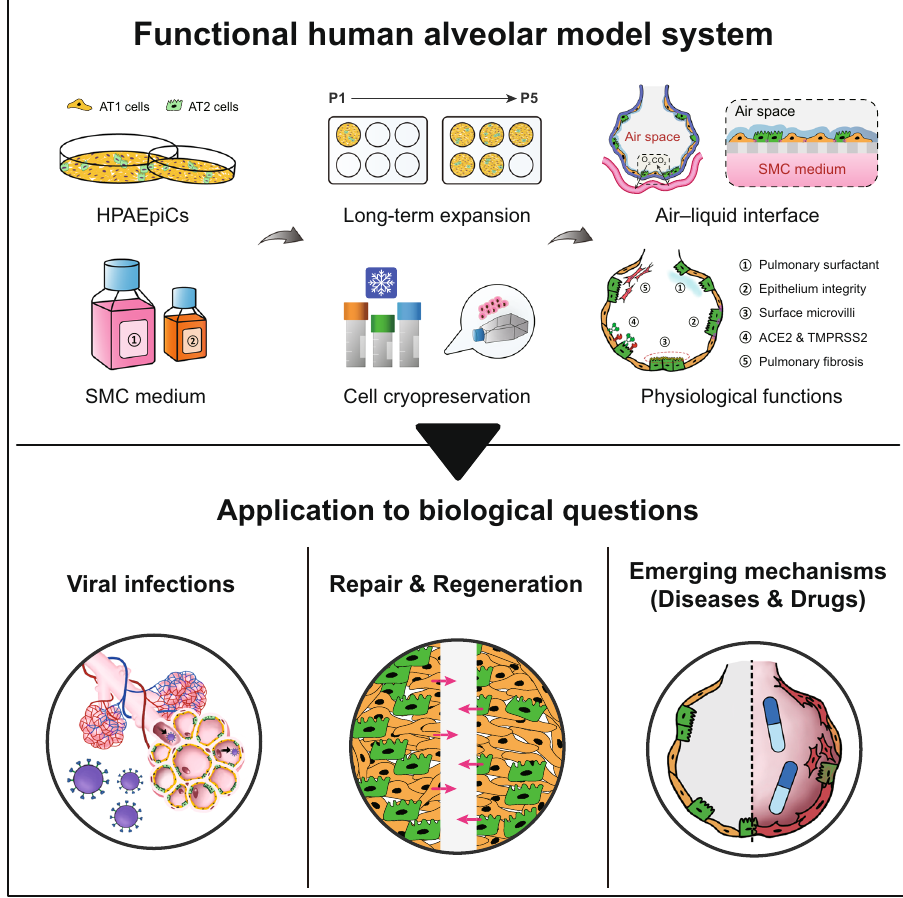
Fig. 6 Schematic summary of functional human alveolar model and potential applications. In this study, a customized SMC medium was developed to support long-term HPAEpiC expansion and culture while maintaining the AT1 and AT2 cell phenotypes. During ALI modeling, the human alveolar model reproduced the key structural and functional characteristics, which include (1) pulmonary surfactant production, (2) epithelium integrity, (3) surface microvilli, (4) tissue-speci fi c protein expression (ACE2, TMPRSS2), and (5) cellular regeneration and disease development. Following SARS ‐ CoV ‐ 2 infection, the pseudovirus enters both the AT1 and AT2 cells, destroys the pulmonary surfactant (SPA), and induces IL-8 secretion. In the process of repairing the damaged alveolar model, XAV939 greatly improved wound healing and reduced fi broblast activation; thus, the mediation of Wnt signaling is crucial for alveolar regeneration. These applications highlight the fact that a developed human alveolar model system can help researchers investigate additional physiological responses, which enhances human lung research that includes viral infection studies and drug with 20- μ g/ml anti-ACE2 antibodies (Abcam, ab87436) for 30min before infection for blocking the ACE2 receptors on the cell surface. Treatment of lung alveolar model with lipopolysaccharide . Prior to treating the lung alveolar cell model (Sub D7 + ALI D7), the culture medium was replaced with the control medium. Then, 100 μ g/ml LPS (Sigma-Aldrich, L4391) was added to the apical chamber of the Transwell insert for 24 h. The cells were stained with speci fi c antibodies to observe the lung alveolar model barrier function. Wound healing assay . The lung alveolar model for the ALI condition (Sub D7 + ALI D7) established as described above was used in a study of scratch wound healing. The cells on the Transwell insert were gently scratched with a sterile 200- μ l pipette tip (approximate outer ori fi ce diameter: 800 – 900 μ m) to create a straight wound region. The cells were then rinsed twice with DPBS to remove any detached cells and cultured under the ALI condition with the control medium containing 10- process was photographed at 24 and 48 h post-scratching. Cells were then stained with speci fi c antibodies to analyze the wound healing ability. Immuno fl uorescence staining . Following two washes with DPBS, cells were fi xed and permeabilized with the Cyto fi x/Cytoperm Solution (BD Biosciences, 554722) for 15 min. The fi xed cells were incubated with a blocking buffer composed of DPBS containing 1% bovine serum albumin and 5% fetal bovine serum for 30 min; then, they were incubated with primary antibodies (Supplementary Table 5) at